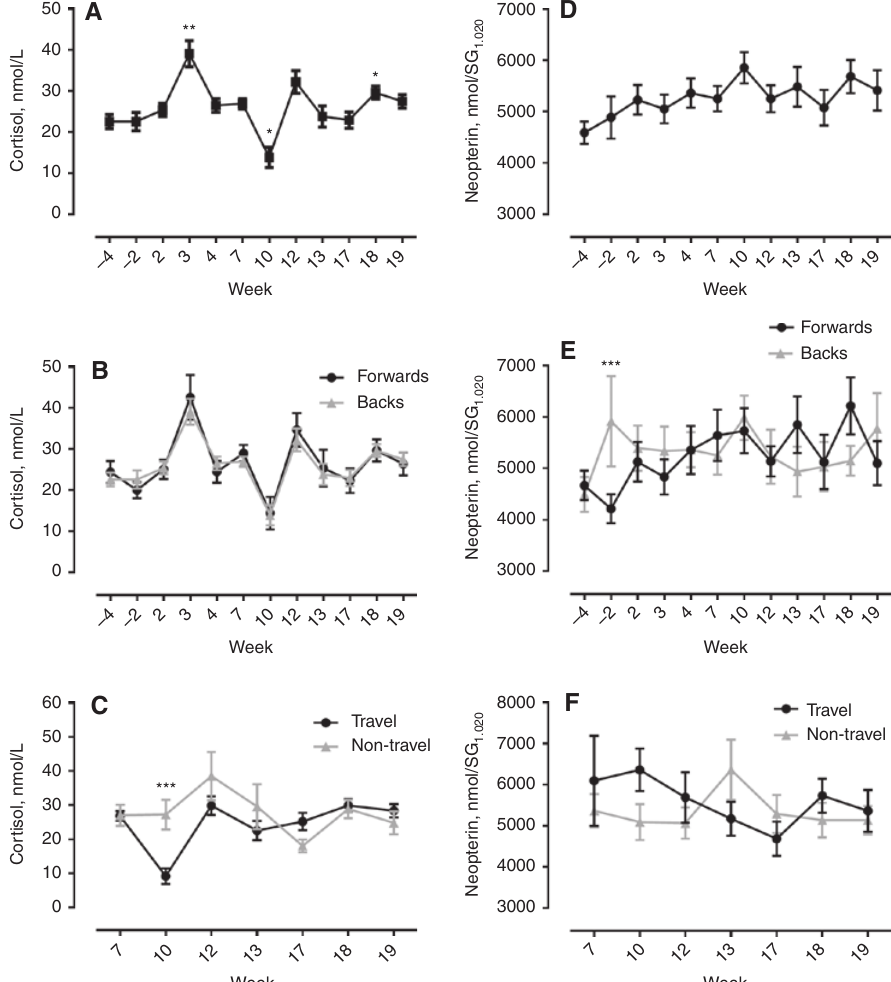
Figure 1: Salivary cortisol for the group (A), forwards vs. backs (B), players who travelled to South Africa vs. those that did not (C) and urinary total neopterin for the group (D), forwards vs. backs (E) and players who travelled to South Africa vs. those that did not (F). Data is presented as mean ± SEM. (*p < 0.05, **p < 0.01, ***p <